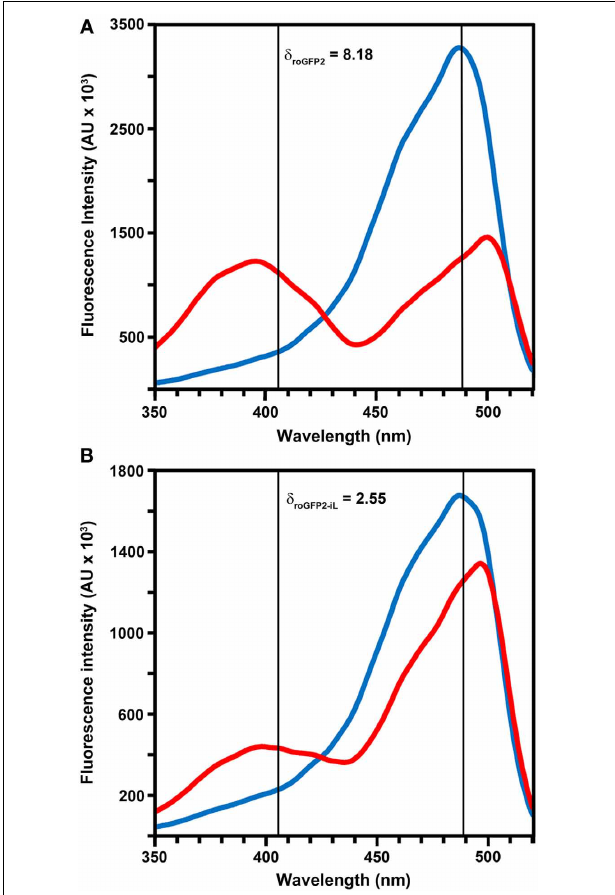
FIGURE 2 | Excitation properties of roGFP2 and roGFP2-iL. Excitation spectra of roGFP2 (A) and roGFP2-iL (B) in fully oxidized (red curve) and fully reduced (blue curve) state. Emission was monitored at 540nm. The maximum dynamic ranges ( δ ) were calculated from the 405/488nm excitation ratios for fully reduced and fully oxidized probes. Both excitation wavelengths are indicated by vertical lines.